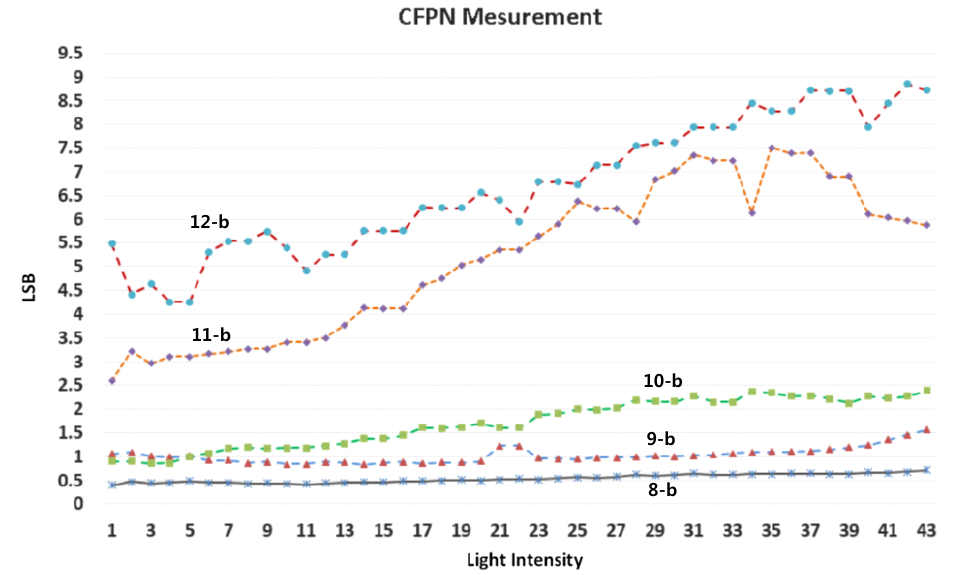
Figure 19. Measured CFPN with the self-calibration for various resolutions (scale of y -axis: 10-bit resolution).